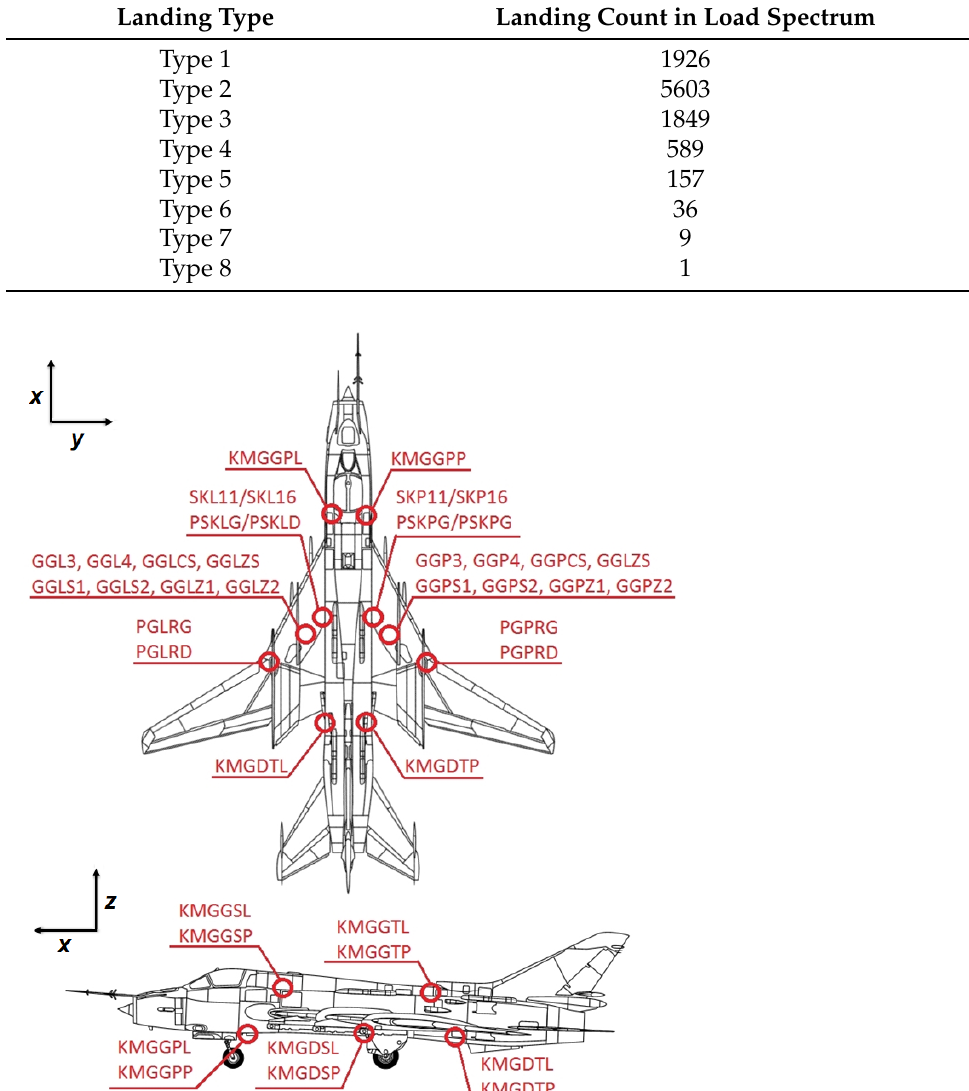
Table 2. Number of different landings type represented during Full-Scale Fatigue Test.